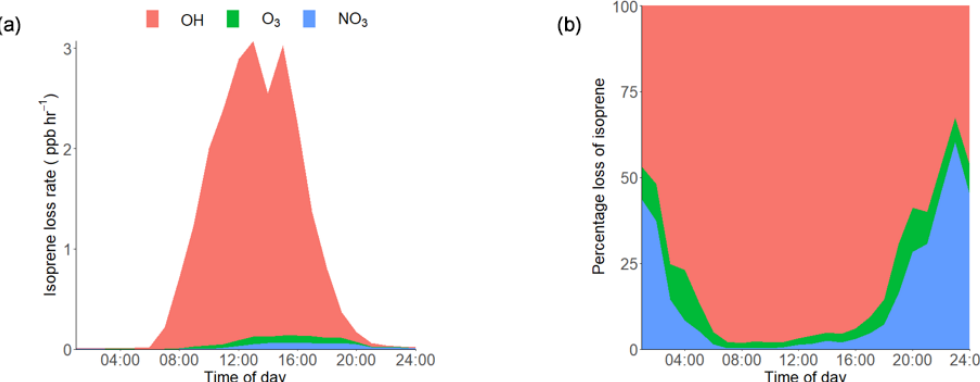
Figure 4. (a) Diurnal loss rate of isoprene calculated using the measured average diurnal profiles of isoprene, OH, NO 3 and O 3 . (b) Average diurnal percentage loss of isoprene from reactions with OH, O 3 and NO 3 radicals. The IUPAC rate constants used for the calculations are as follows: NO 3 , 7 × 10 − 13 molecule − 1 s − 1 ; O 3 , 1 . 27 × 10 17 molecule − 1 s − 1 ; OH, 1 × 10 10 cm 3 molecule − 1 s − 1 (Atkinson et al.,